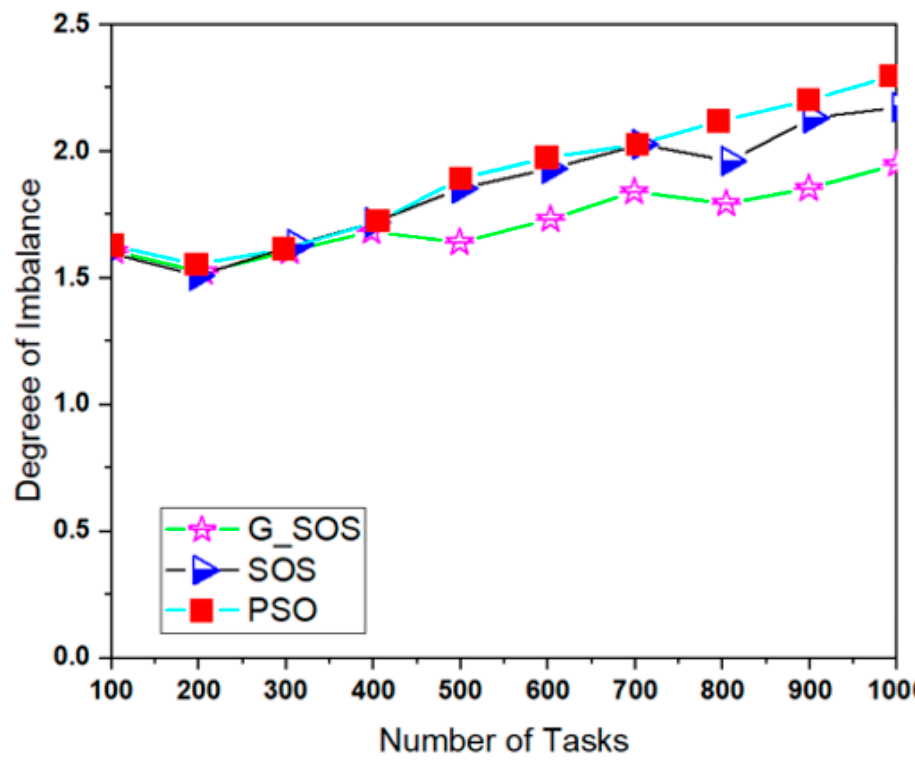
Figure 4. Response comparison between G_SOS, SOS and PSO (uniform distribution).